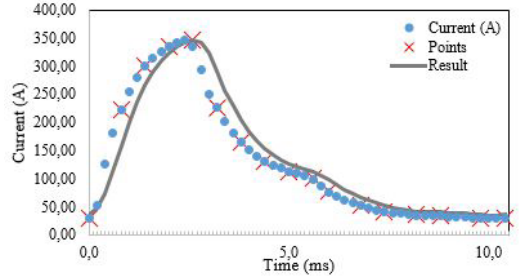
Figure 5. Result Fronius GMAW pulsed waveform.